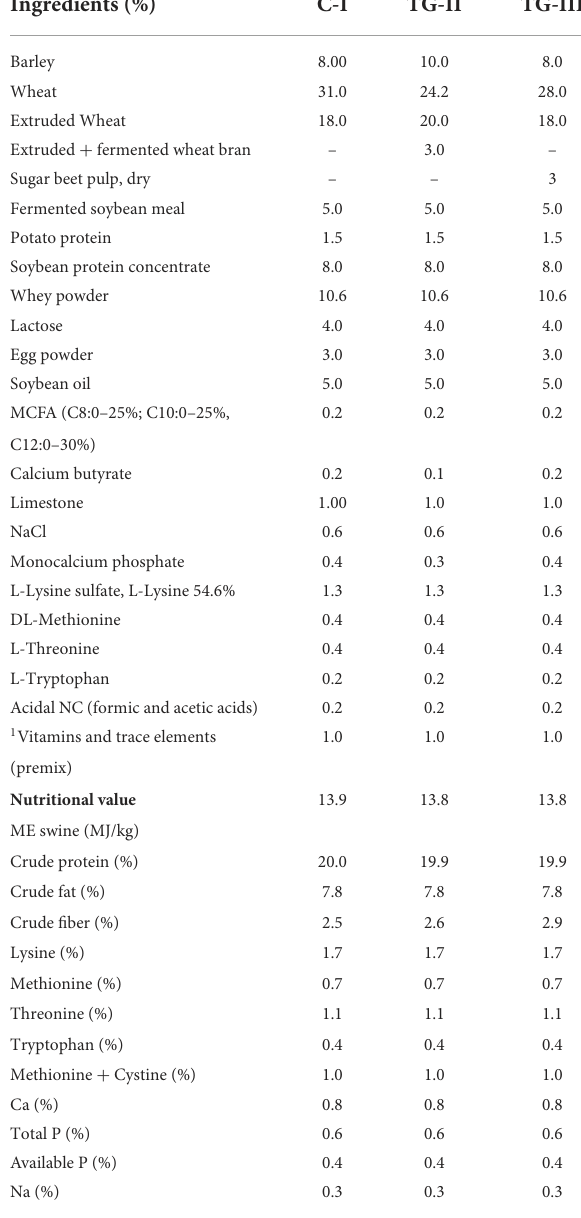
TABLE 1 Composition of control and experimental piglet